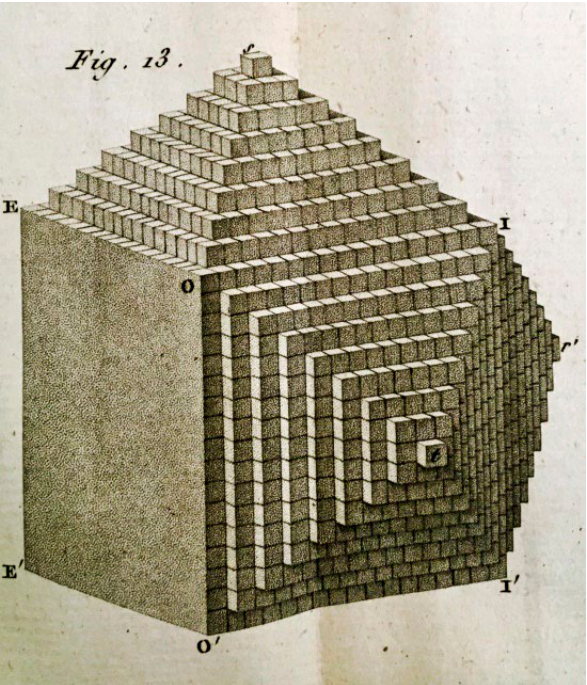
Figure 5. Haüy’s model of a cubic crystal showing the periodic translation of a basic cubic building block (integrant molecule) and how different crystallographic forms can be obtained subtracting integrant molecules from an original cube. (From reference 13, vol. 5, fig. 13).